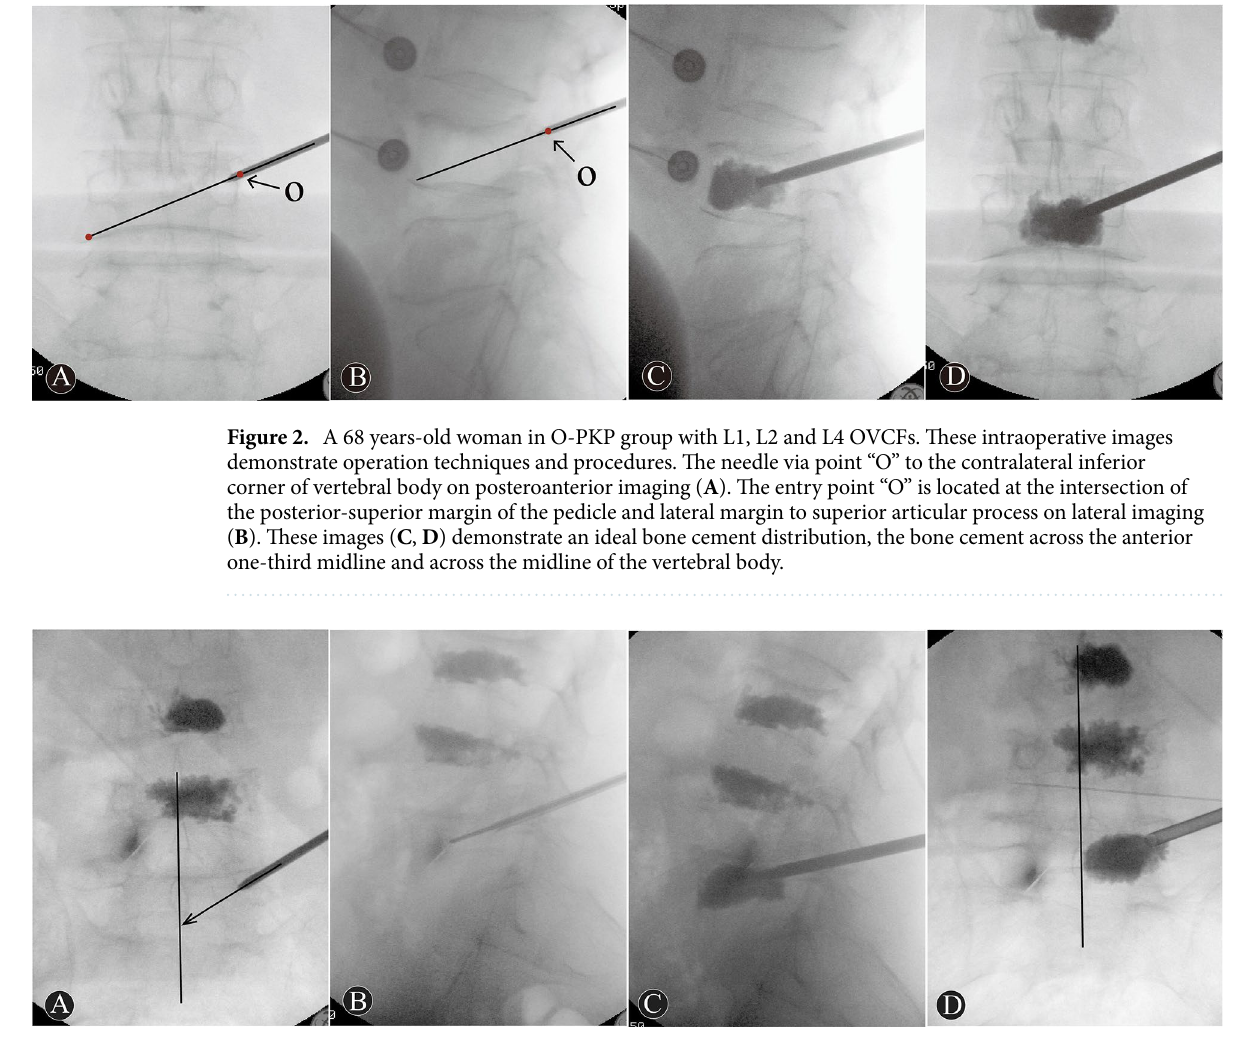
Figure 3. A 69 years old female patient in T-PKP group with L5 OVCF, previous PKP history of L3 and L4. These images are intraoperative X-ray fluoroscopy. The posteroanterior imaging ( A ) showed that the needle inclined to the midpoint of inferior endplates. The needle via the pedicle reached anterior 1/3 part of the vertebral body ( B ). The anteroposterior distribution of bone cement was satisfactory ( C ). Bone cement don’t across the midline of the vertebral body ( D